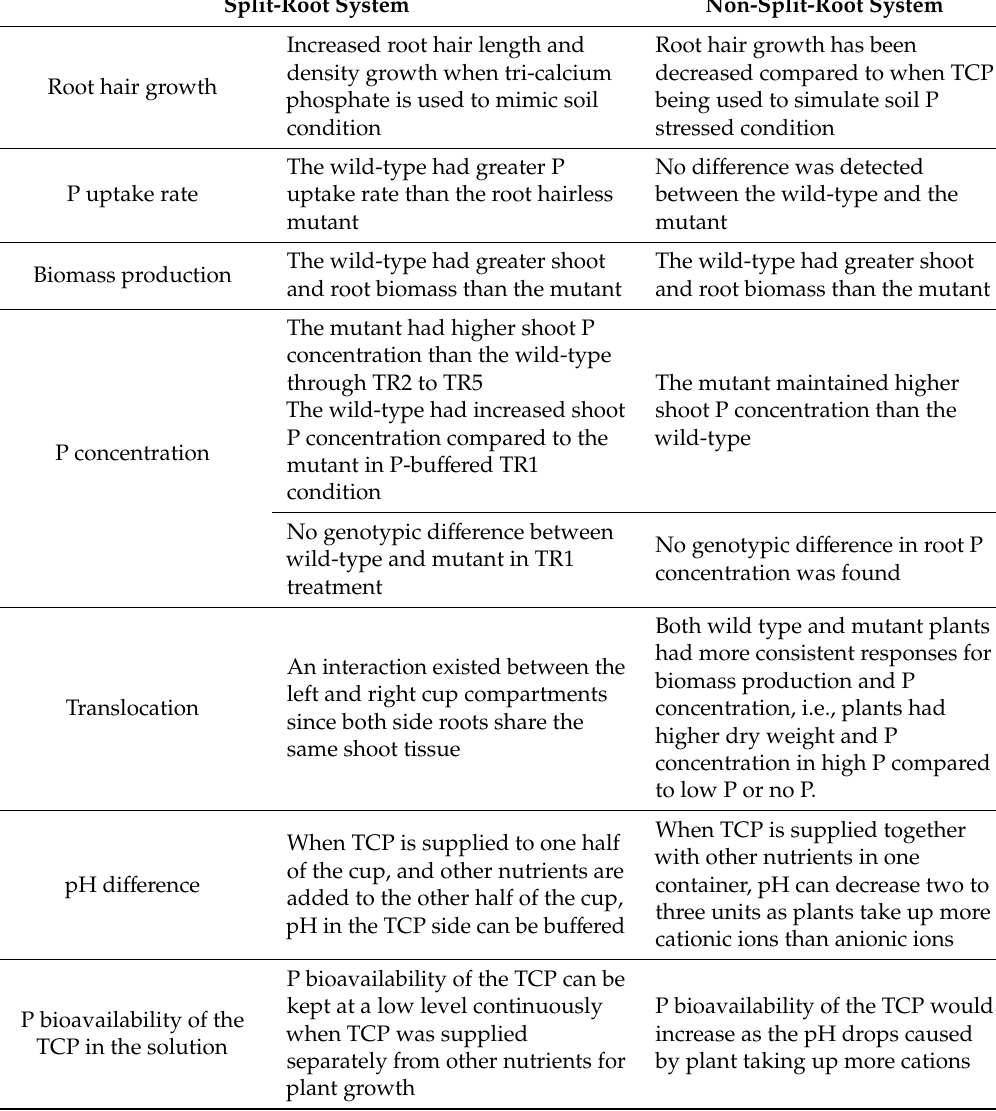
Table 4. Comparison of P uptake and plant growth between split-root system and non-split-root system in response to external P concentration in the nutrient